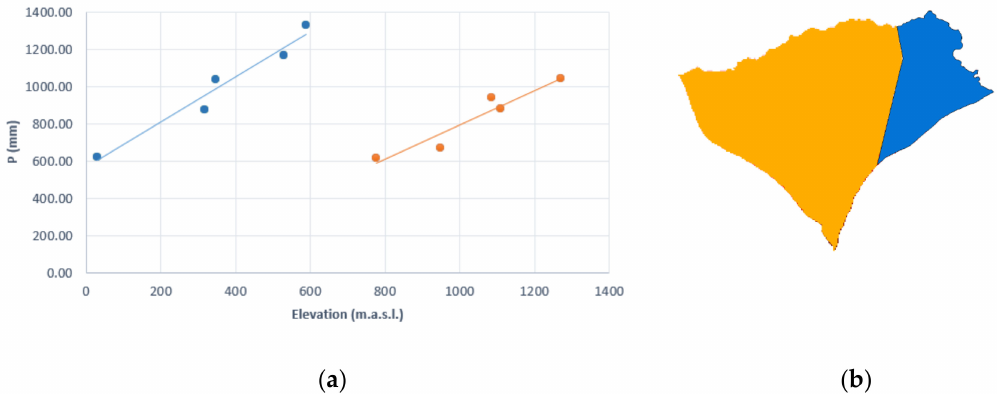
Figure 4. ( a ) Linear regressions between rainfall ( p ) and elevation (m a.s.l.) ( b ) Sub-areas of Northern Etna groundwater aquifer.